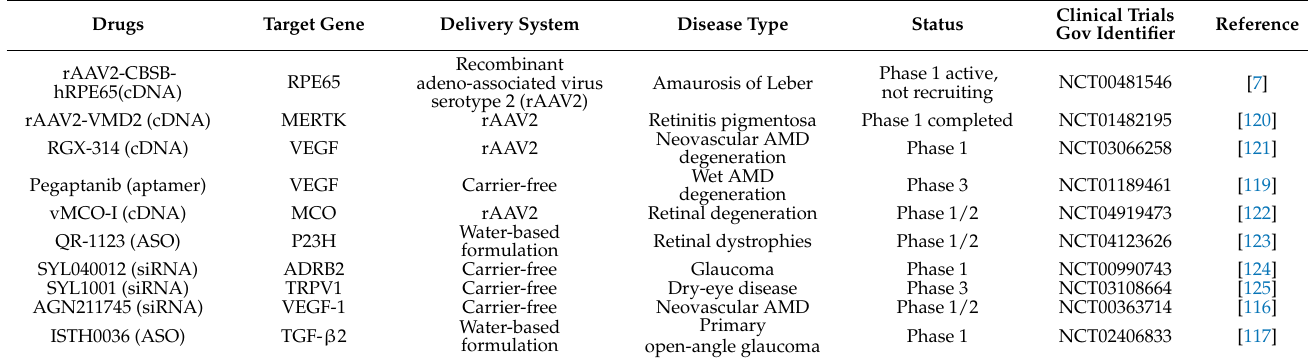
Table 5. NAD clinical